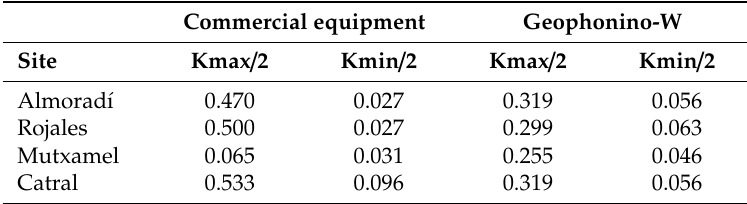
Table 2. Theoretical wavenumber limits (rad / m) for the di ff erent geometries